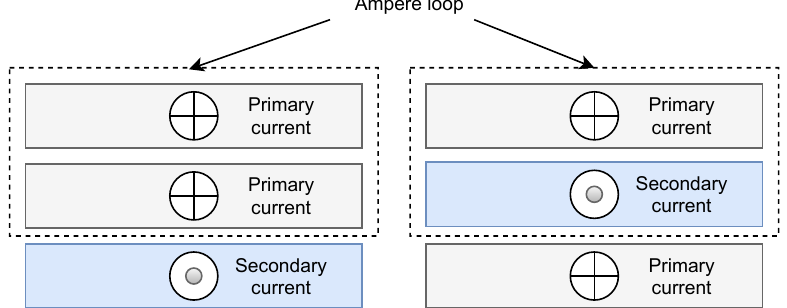
Figure 1. Non-interleaving windings ( Lef t) and interleaving windings ( Right